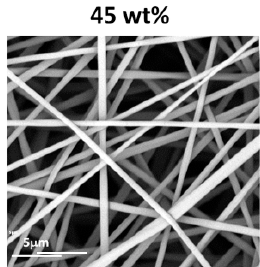
Figure 5. Morphology of P(iPrOx–nPrOx) 51k fibres obtained at a concentration of 45 wt % in water (flow rate of 1 mL / h).